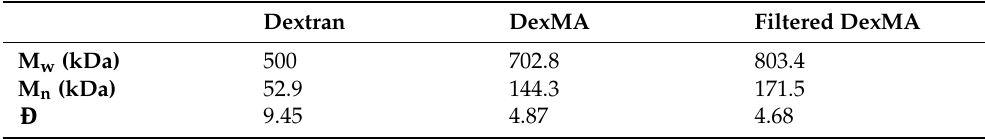
Table 4. Molecular weights and molecular weight distributions of dextran, DexMA, and DexMA passed through a 0.22 µm filter. The polymer solutions were analyzed via GPC calibrated using dextran standards. Dextran with a theoretical methacrylation degree of 20%. DexMA: dextran methacrylate, Ɖ : dispersity (Mw/Mn).